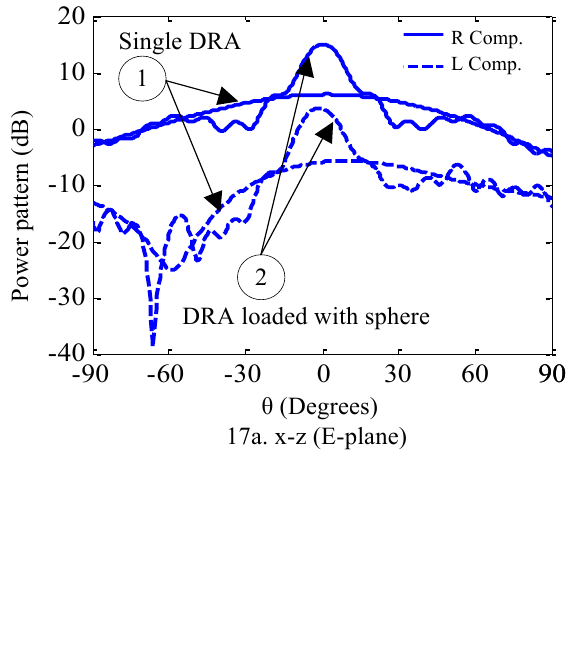
Figure 16: The gain and the axial ratio versus frequency for DRA loaded with dielectric sphere compared to a single DRA.